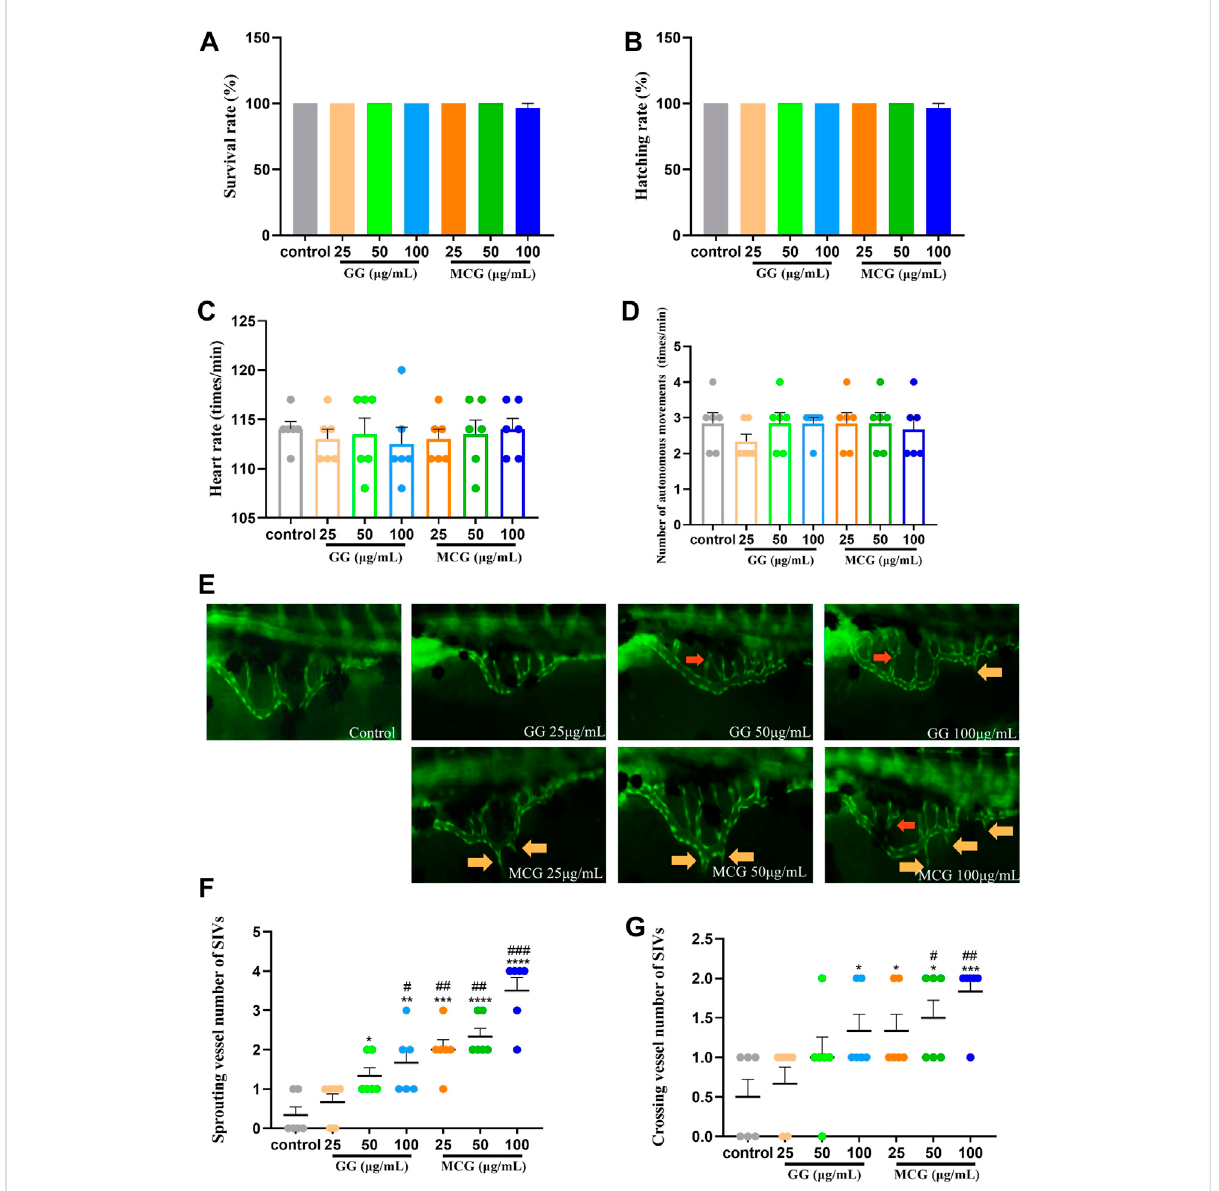
FIGURE 4 EffectofMCGandGGonsubintestinalvesselplexus(SIV)growthinzebra fi sh.Healthyembryosthatweredeveloped24 hpost-fertilization(hpf) were removed and treated with various concentrations of MCG and GG (25, 50, 100 μ g/ml) for 48 h. (A,B) Survival rate and hatching rate of 72 hpf zebra fi sh embryos. (C,D) Heart rate and number of autonomous movements of 72 hpf zebra fi sh embryos. (E) SIV growth after MCG and GG treatment in zebra fi sh. Red arrows indicate the crossing vessels, and yellow arrows indicate the sprouting vessels of SIVs. (F,G) Sprouting and crossingvesselnumbersofSIVswerecalculatedineachembryo,anddataarerepresentedasthemean±standarderrorofthemean. n =3.* p < 0.05, ** p < 0.01, *** p < 0.001, **** p < 0.0001 versus the control group. # p < 0.05, ## p < 0.01, ### p < 0.001 compared with the GG (25 μ g/ml)-treated